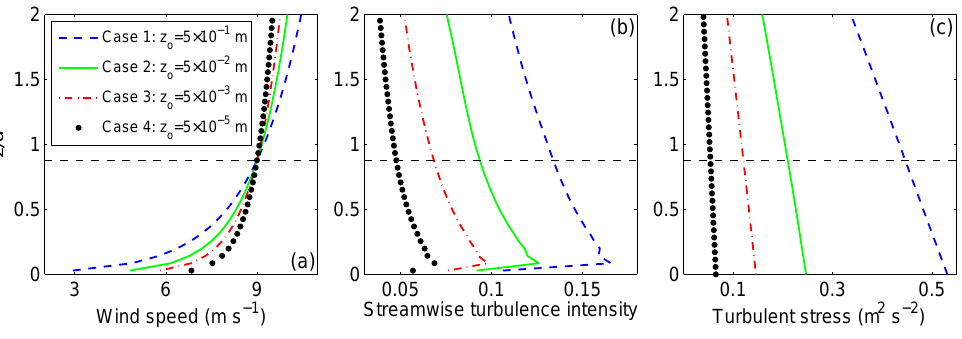
Figure 2. Vertical profiles of ( a ) the time-averaged streamwise velocity u (m s − 1 ); ( b ) the streamwise turbulence intensity I ; and ( c ) the kinematic shear stress − u (cid:48) w (cid:48) (m 2 s − 2 ) of the u incoming ABL flows over flat surfaces with the four different roughness